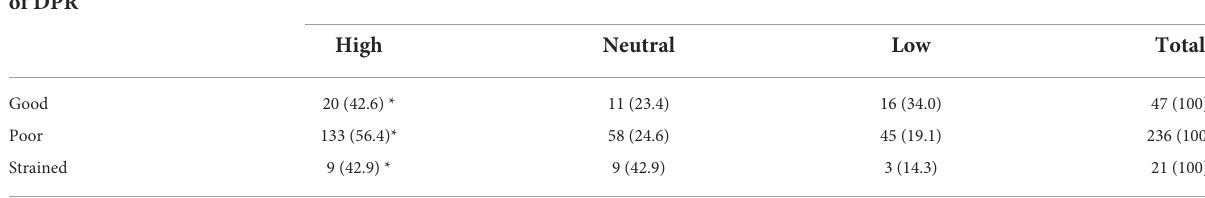
TABLE 7 Preferences for shared decision-making (SDM) among physicians with different evaluations of doctor–patient relationship (DPR) [ n (%)]. Evaluation of